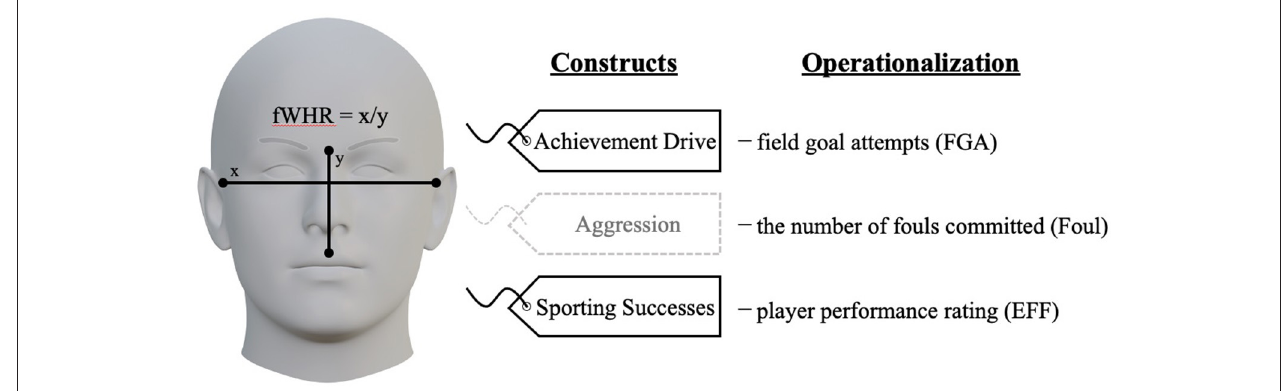
FIGURE 1 | The summary of the